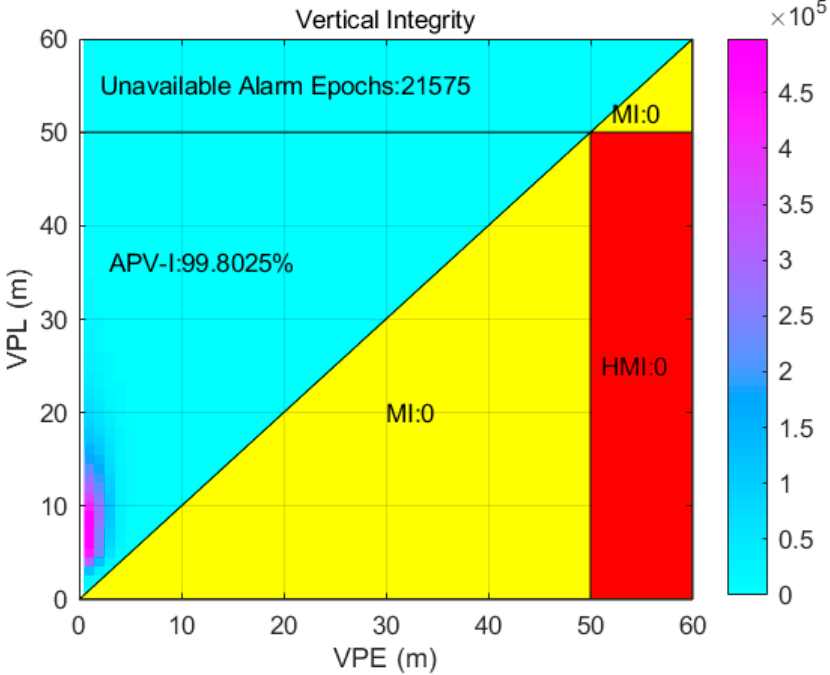
Figure 8. Vertical integrity assessment with Stanford diagram. No misleading information (MI) and no hazardously misleading information events exist. The 99.8025% testing epochs are operating within their normal bounds in vertical direction according to APV-I approach requirement.